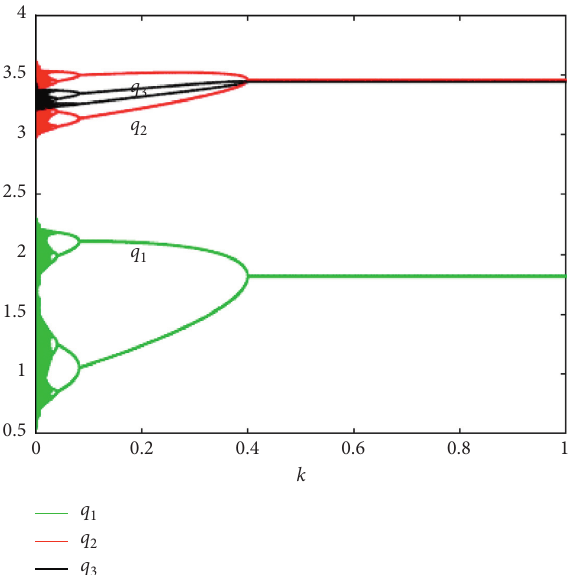
Figure 9: Corresponding bifurcation diagram of system (29) with control parameter k .